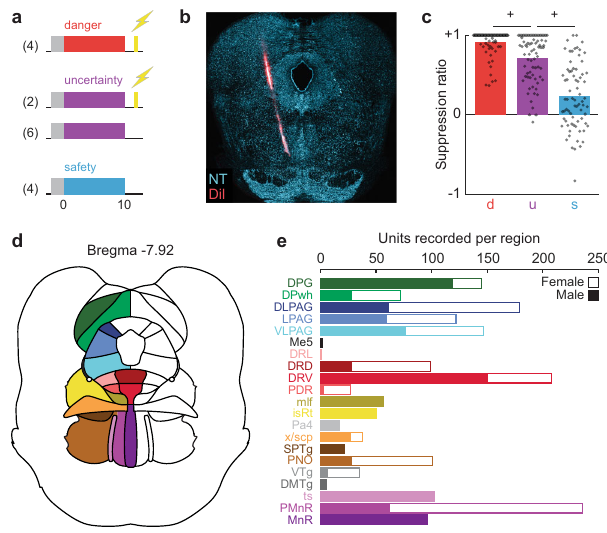
Fig. 1 | Fear discrimination and neuropixels implant. a Probabilistic fear dis- crimination procedure. b Representative neuropixels implant. c Cue suppression ratios during recording sessions ( n =73). d Summary of brainstem regions recor- ded. e Number of single units recorded from each brainstem region by sex ( n =1812, female n =965). + indicates 95% bootstrap con fi dence interval does not containzero.ddanger,uuncertainty,ssafety.SourcedataareprovidedasaSource Data fi